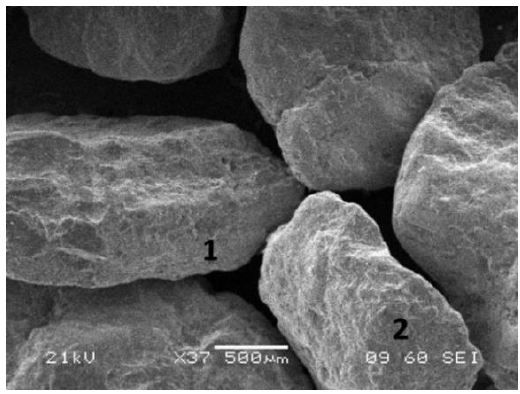
Figure 8. Scanning electron microscopy (SEM) image (×100) of the residue sample. Particles identified: limonite (1); chrysocolla (2).